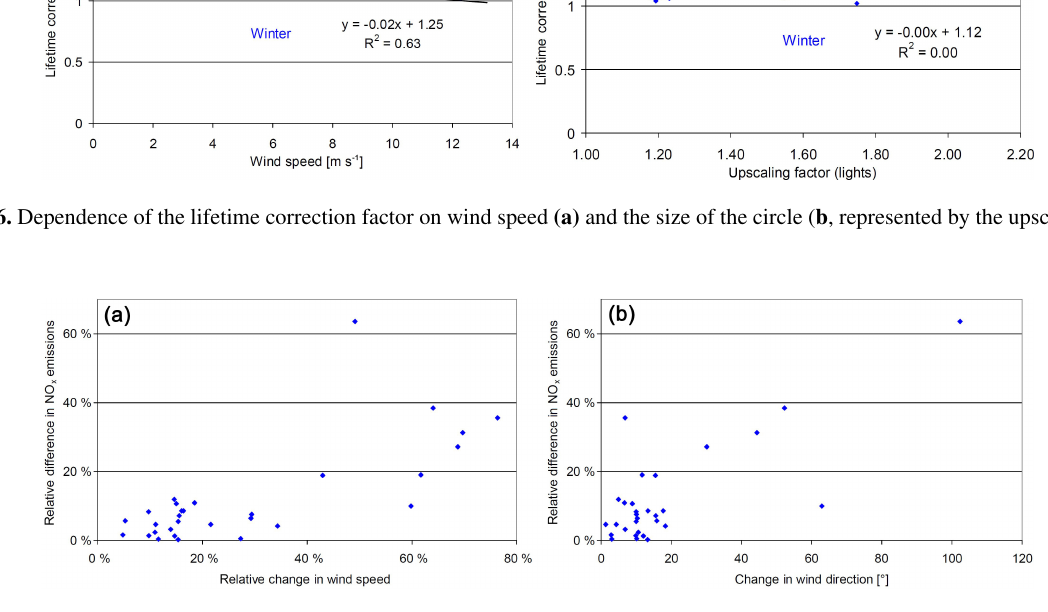
Figure A7. Difference in the NO x emissions derived with either averaged or variable wind data plotted versus the variability in the wind speed (a) and wind direction (b) .